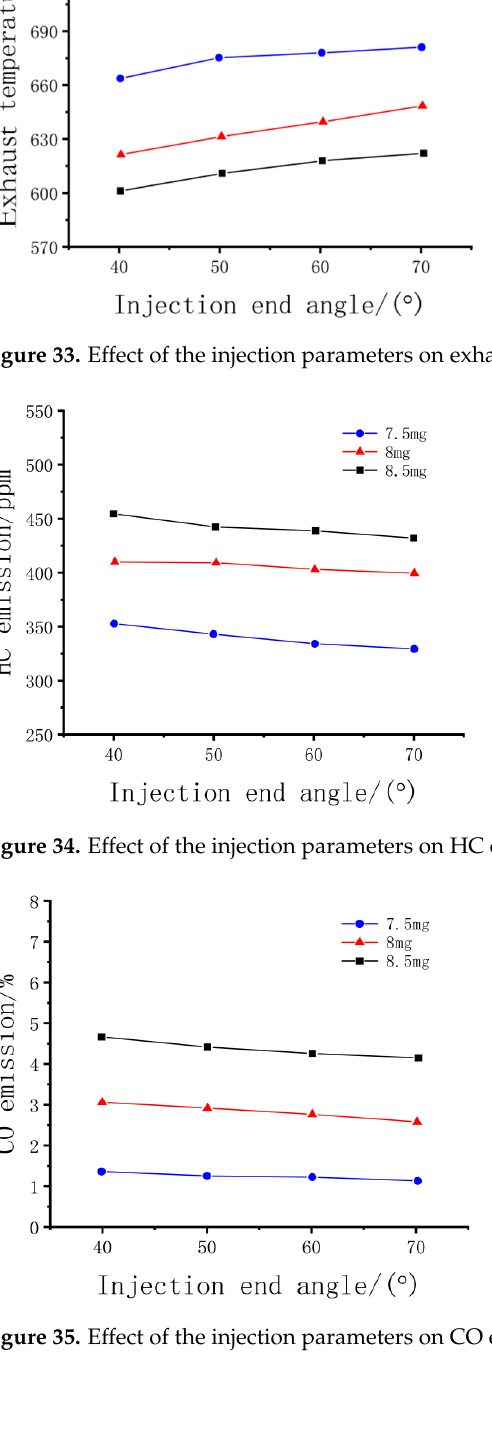
Figure 32. Effect of the injection parameters on fuel consumption.